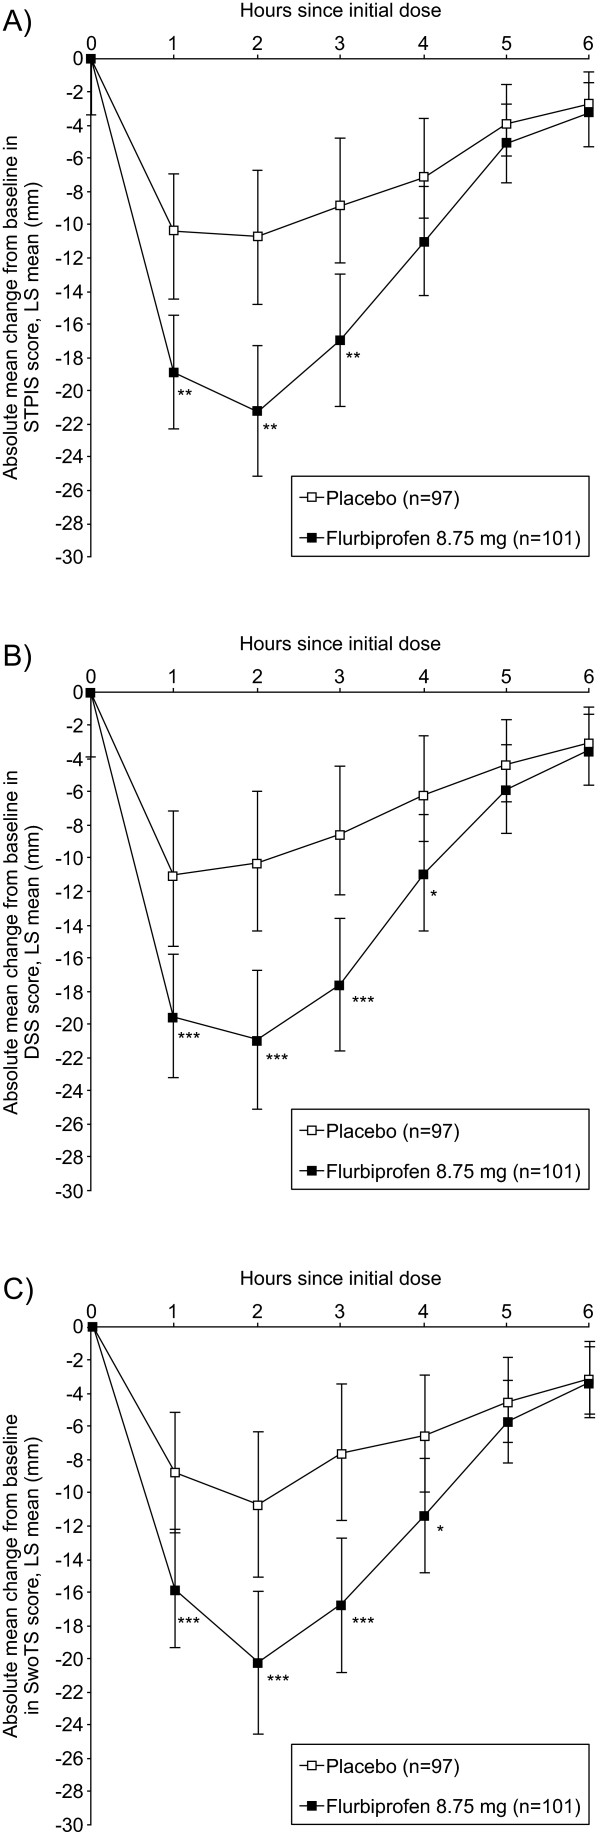
Efficacy of a single flurbiprofen 8.75 mg or placebo lozenge over six hours. ANOVA was used to compare flurbiprofen 8.75 mg (n = 101) and placebo (n = 97 up to two hours, n = 96 from three to six hours, as one patient withdrew from the study) for the effects of a single dose on absolute mean change over six hours in A) sore throat pain (on the STPIS), B) difficulty swallowing (on the DSS), and C) swollen throat (on the SwoTS). Error bars represent the 95% CIs. *P <0.05, **P <0.01, ***P <0.001 compared with placebo. ANOVA, analysis of variance; CI, confidence interval; DSS, Difficulty Swallowing Scale; LS, Least square; STPIS, Sore Throat Pain Intensity Scale; SwoTS, Swollen Throat Scale.